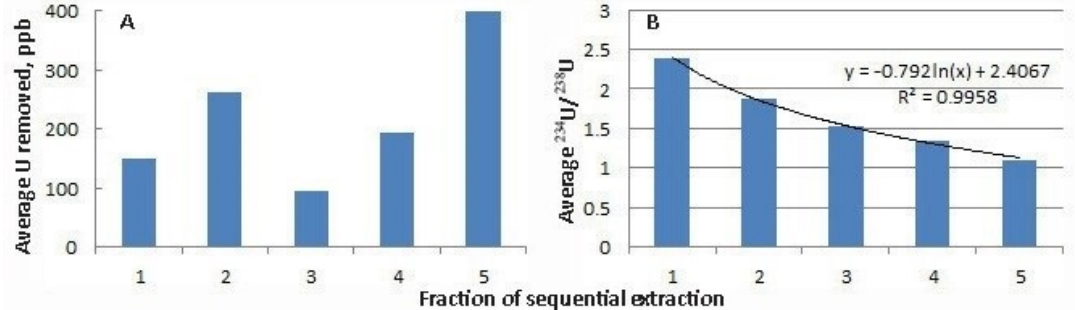
Figure 3. Average distribution of uranium (ppb of rock) ( A ) and the ratio of the activities of its isotopes ( B ) in extracted phases 1–5. 1—Adsorbed trace materials and carbonate minerals; 2—Ferrihydrate, amorphous minerals of Fe, Al, and Si, and secondary U minerals; 3—Crystalline iron minerals; 4—Clay and some refractory minerals; 5—All remaining resistant minerals.